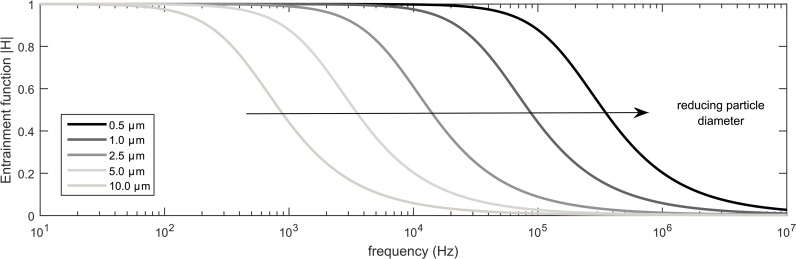
Effects of frequency and particle diameter on entrainment.A small value of entrainment function |H| indicates that the particle is relatively motionless in the acoustic field and a value close to 1 means that the particle is fully entrained and oscillates with the gas medium.